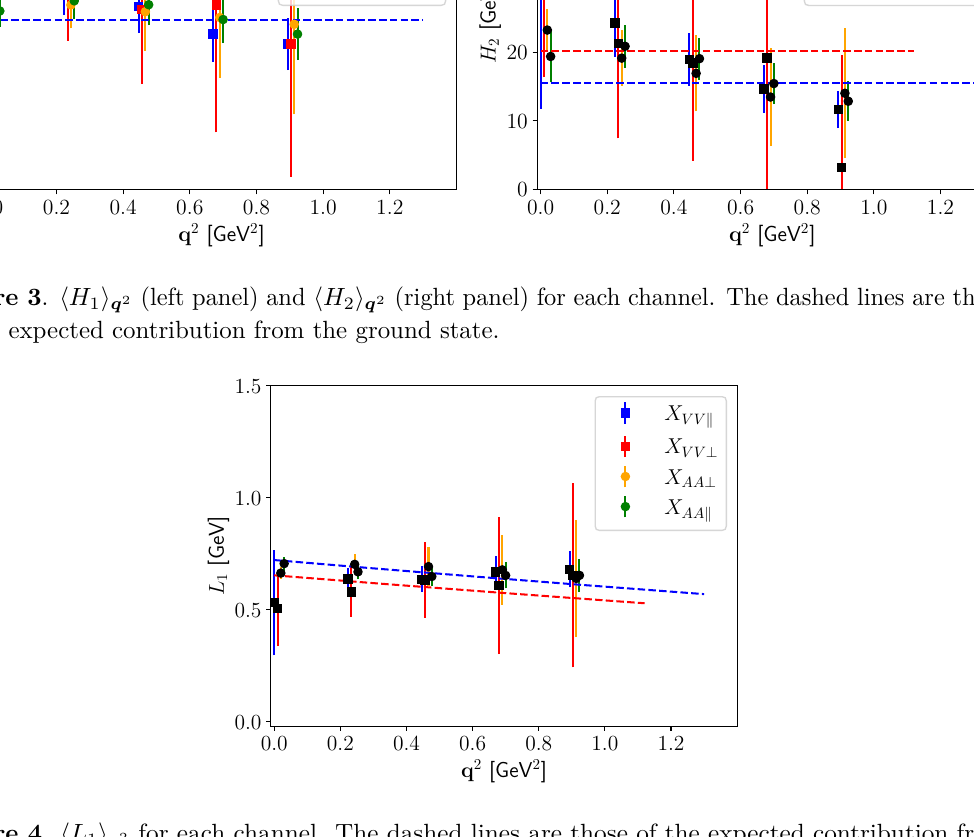
Figure 4 . h L 1 i for each channel. The dashed lines are those of the expected contribution from q 2 the ground